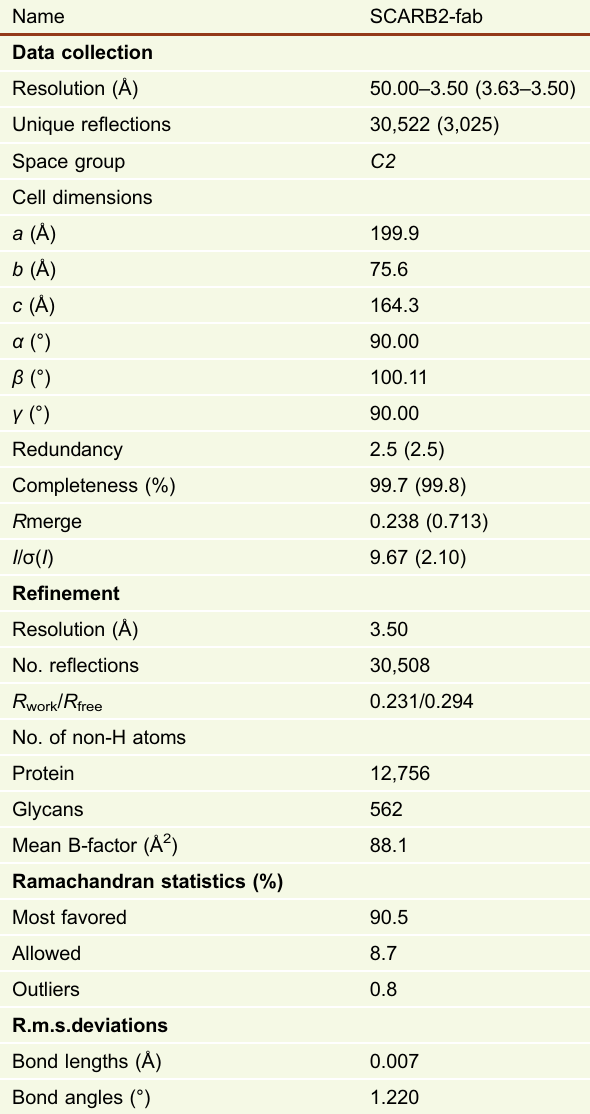
Table 1. Data collection and re fi nement